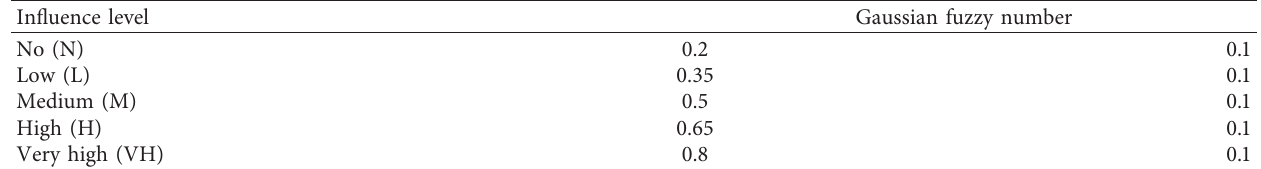
Table 2: Linguistic variables for Gaussian fuzzy